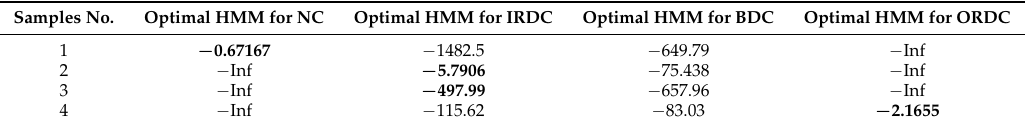
Table 8. Recognition results of fault types based on the